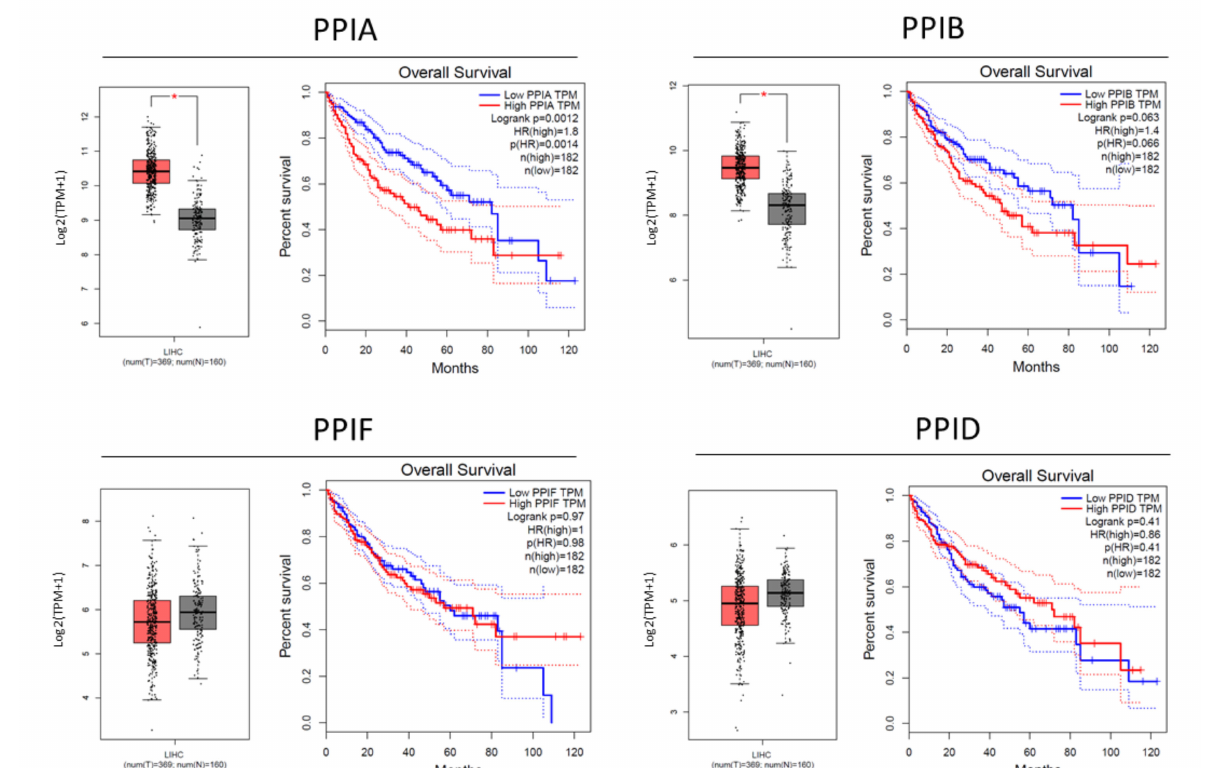
Figure 1. HCC gene expression and survival curves retrieved from GEPIA. Left graphs represent the gene expression levels of PPIA, PPIB, PPIF and PPID in HCC evaluated from The Cancer Genome Atlas (TCGA) tumors vs. TCGA normal + Genotype-Tissue Expression (GTEx) normal analyzed by one-way ANOVA. Tumor is indicated in red and normal tissue in grey. * p < 0.01 statistical difference in comparison to normal tissue. Right graphs represent Kaplan–Meier plots for the overall survival from 364 HCC patients in relation to the expression levels of the PPIA, PPIB, PPIF and PPID genes. Group cutoff is presented in a median at 50% for high and